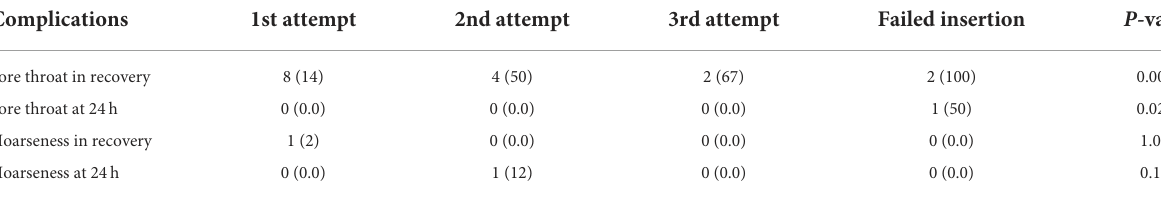
TABLE 4 Post-operative complications and number of PLMA insertion